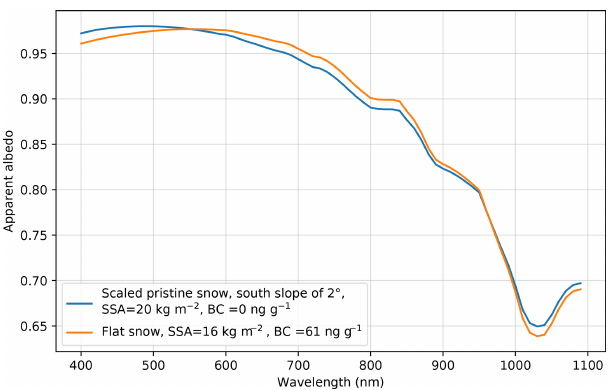
Figure 8. Example of scaled spectrum of pristine snow affected by a small slope (2 ◦ ) and comparison to dirty snow spectrum with fitted SSA and black carbon (BC)